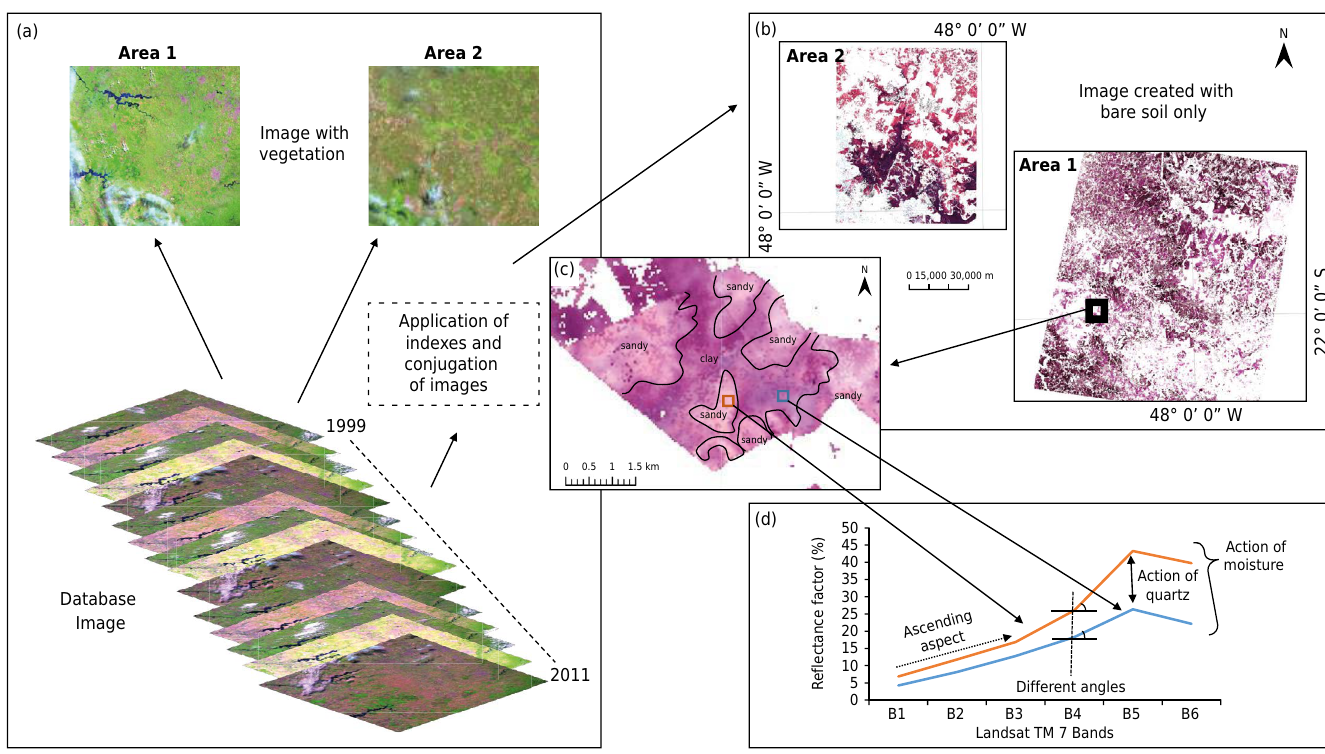
Figure 3. Simulation of the database image used in construction of the bare soil mask. There are images with maximum plant cover (a); the bare soil mask of the two study areas (b); detail of an exposed soil region in which it is possible to differentiate sandy and clayey areas (c); point spectral response of the pixel taken from the sandy and clayey region (d).